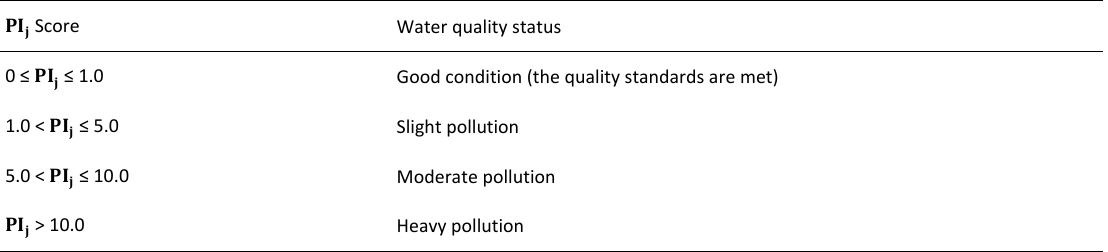
Table 3: Water quality status based on pollution index values (MNLH, 2003) Score